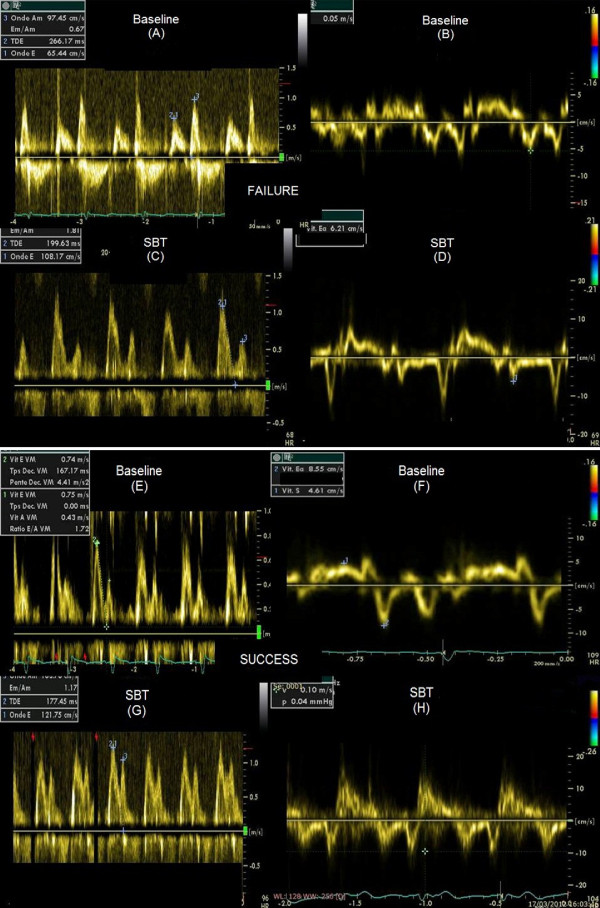
Doppler figure with E/Ea measurement at baseline and during SBT in success and failure. (A) Represents tissue Doppler of mitral annulus at baseline, amplitude of early diastolic wave Ea is 5 cm/sec, the resultant E/Ea ratio is 13. (B) E increases during SBT to 108 cm/sec. (C) Ea is 6.2 cm/sec, the resultant E/Ea increases during SBT to 17.4. (D) Represents pulsed Doppler of mitral flow at baseline in a patient who succeeded, E is 74 cm/sec. (E) Ea is 8.5 cm/sec, the resultant E/Ea is 8.7. (F) E increases during SBT to 121 cm/sec. (G) In the same way Ea increases to 10 cm/sec, then E/Ea ratio remains low during SBT at 12.1.